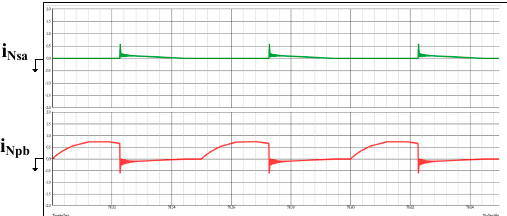
Figure 21. Simulation of current waveforms (i Nsa, i Npb ), i Nsa, i Npb : 500 mA/div, Time: 20 µs/div.